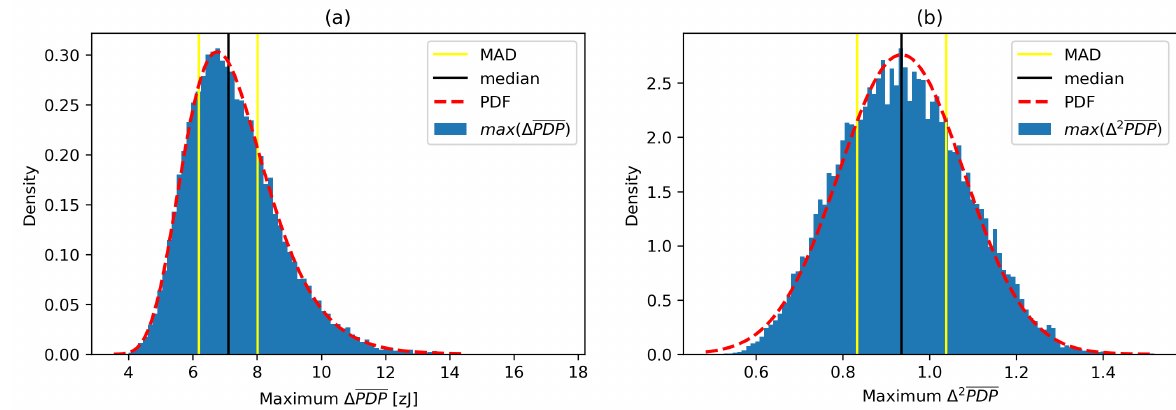
Figure 9. Histograms and probability distributions of windowed ( a ) maximum ∆ PDP values and ( b ) maximum ∆ 2 PDP values. Median and MAD of online maximum ∆ PDP values are median ∆ max = 7.11 × 10 − 21